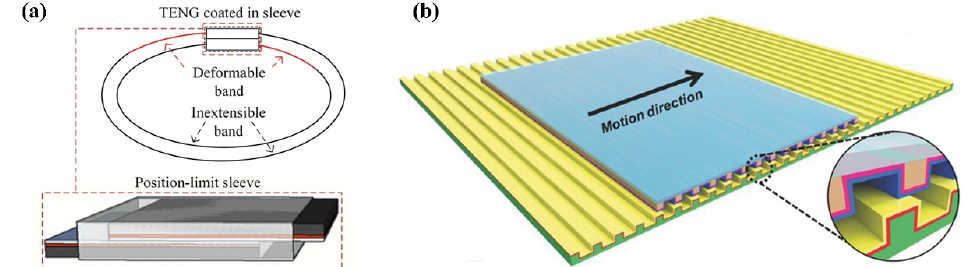
Figure 2. Structures of sliding mode TENGs: ( a ) A wearable TENG integrated into a deformable band (Reproduced with permission [21]. Copyright 2019 The Authors); ( b ) A TENG with grating structures (Reproduced with permission [33]. Copyright 2019 WILEY-VCH Verlag GmbH & Co., KGaA, Weinheim, Germany).